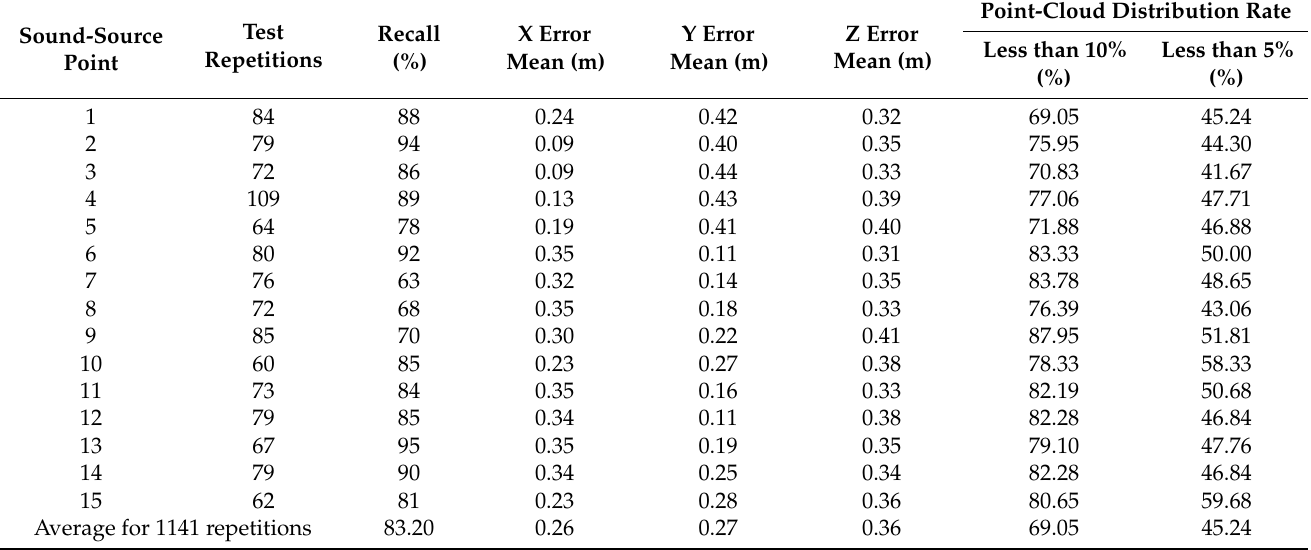
Table 5. Results of the interior construction site validation test 1.